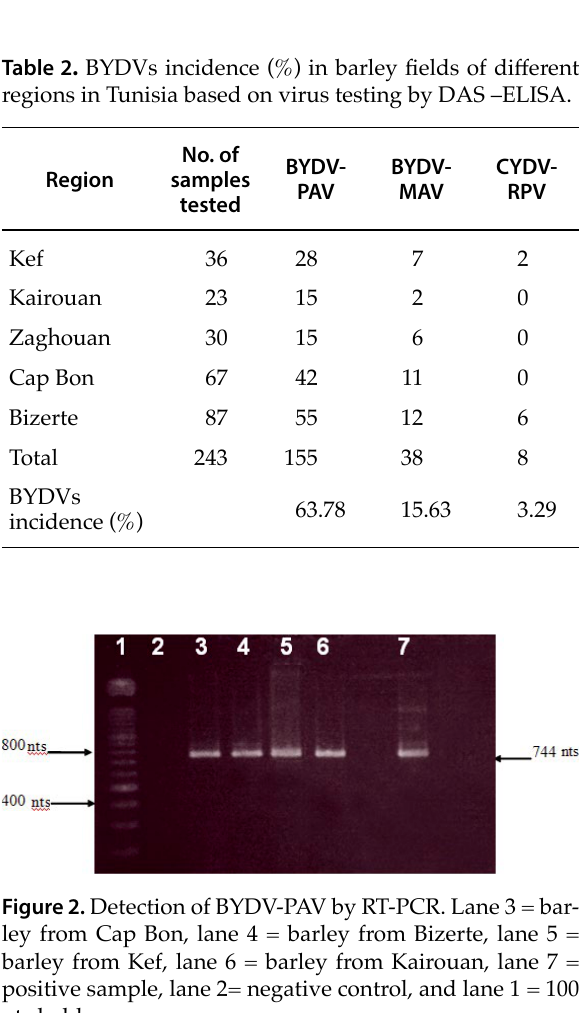
Figure 1. BYDV incidence based on TBIA tests of sympto- matic and randomly selected samples collected from dif- ferent barley regions of Tunisia during April 2012.